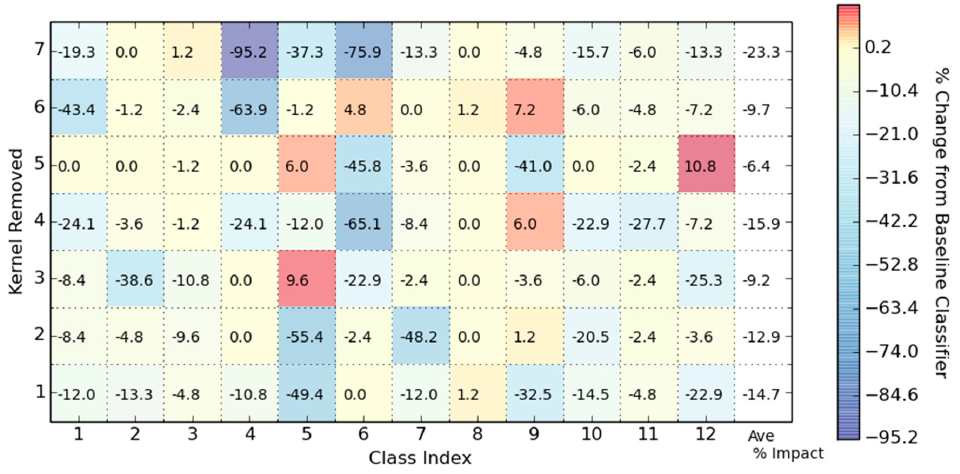
Figure 9. Kernel Importance Matrix. This table shows the percent change in producer accuracy when zeroing a kernel from the CNN. Class index definitions found in Table